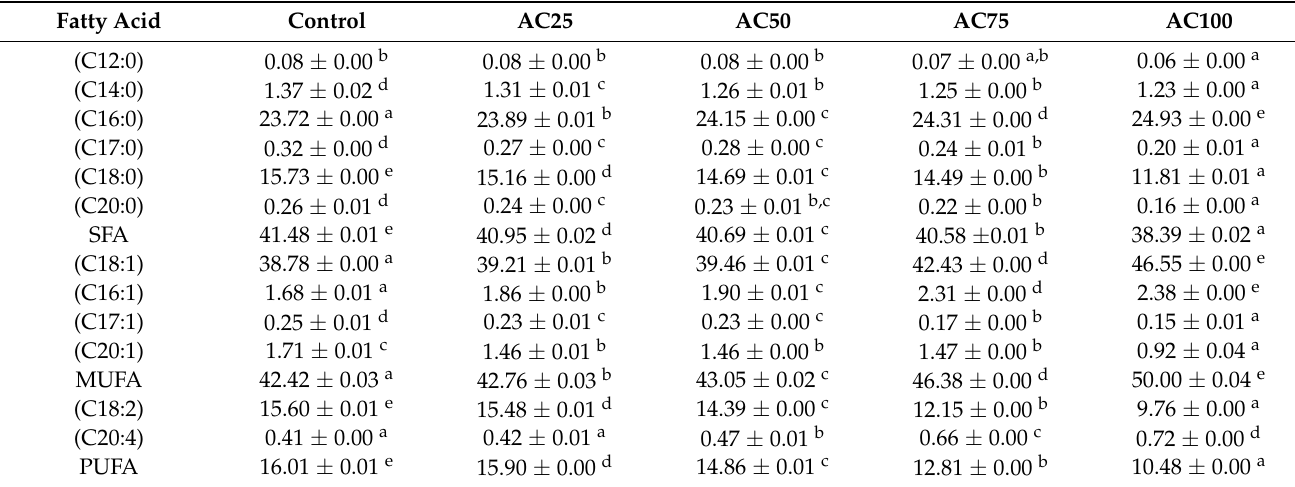
Table 5. Free fatty acids of sausages with substitution of pork fat by Auricularia cornea (AC). Fatty